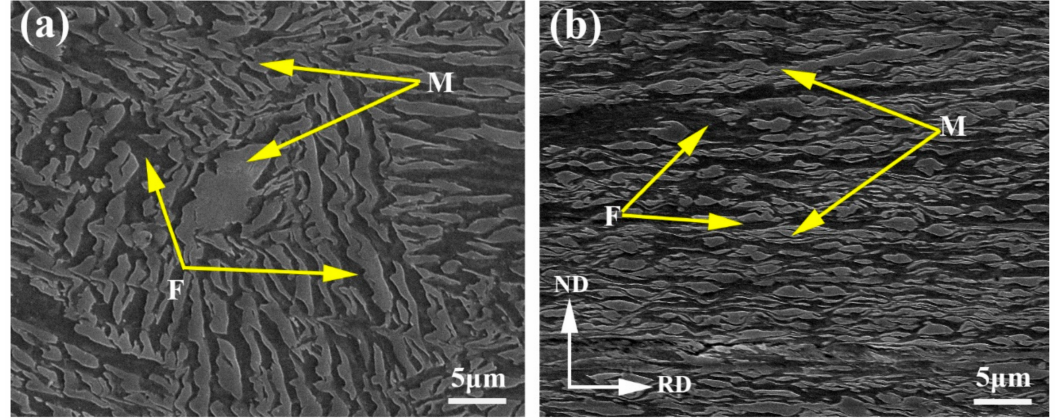
Figure 3. SEM morphologies of the fibrous DP microstructures after ( a ) water quench; and ( b ) cold